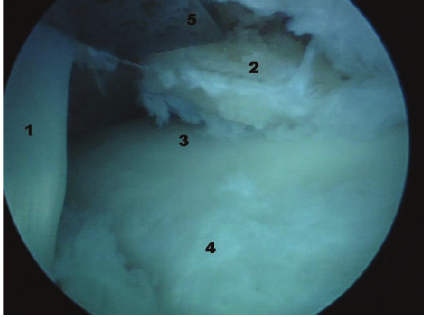
Figure 2: Endoscopic views posteromedial ankle joint. 1. Scarring of the flexor hallucis longus tendon. 2. Posteromedial fragment of the tibia. 3. Posterior ankle joint. 4. Processus posterior tali. 5.